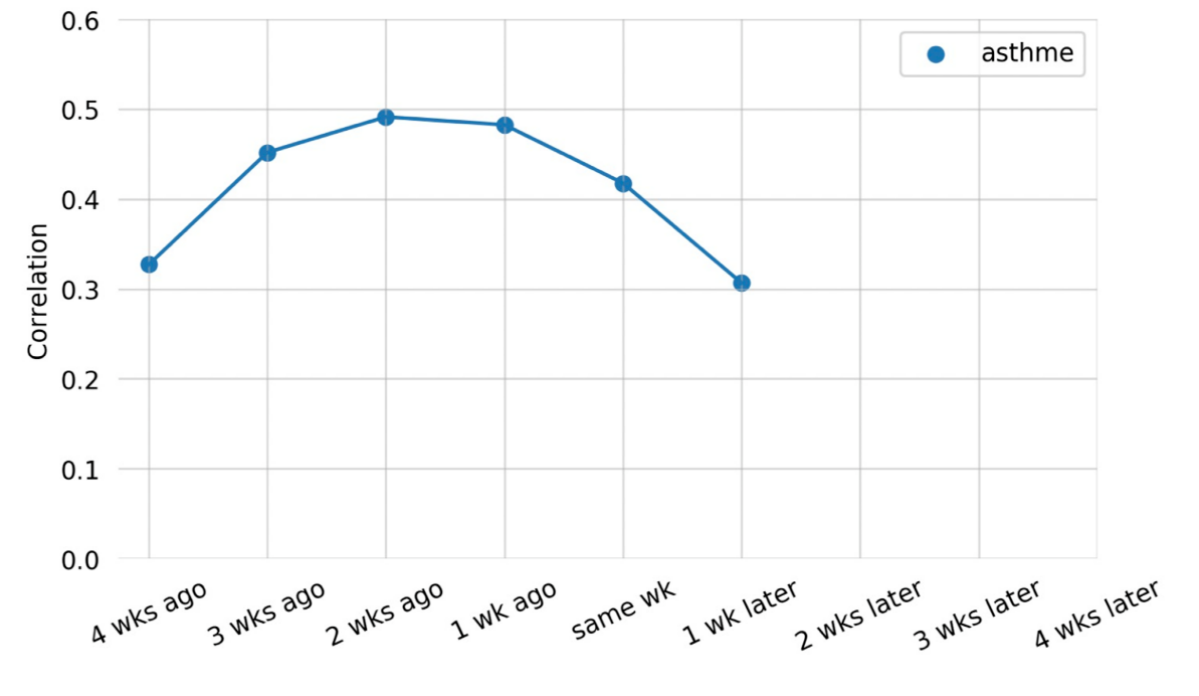
Figure 2. Lag correlation between searches and admissions for “asthme,”